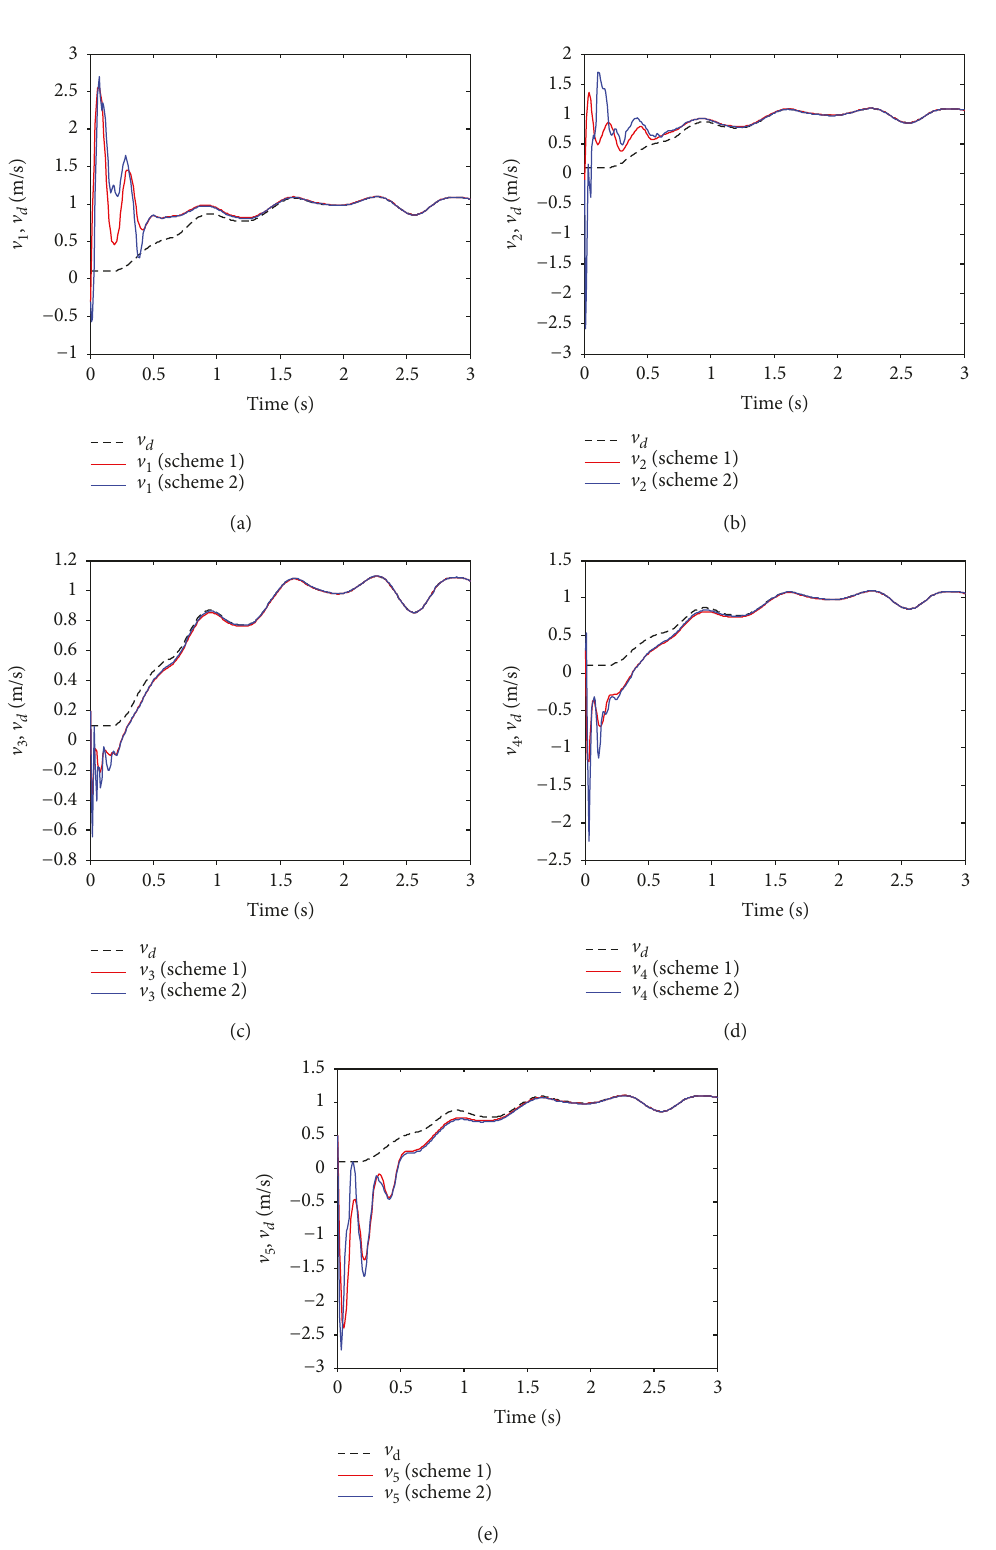
Figure 7: Velocity tracking